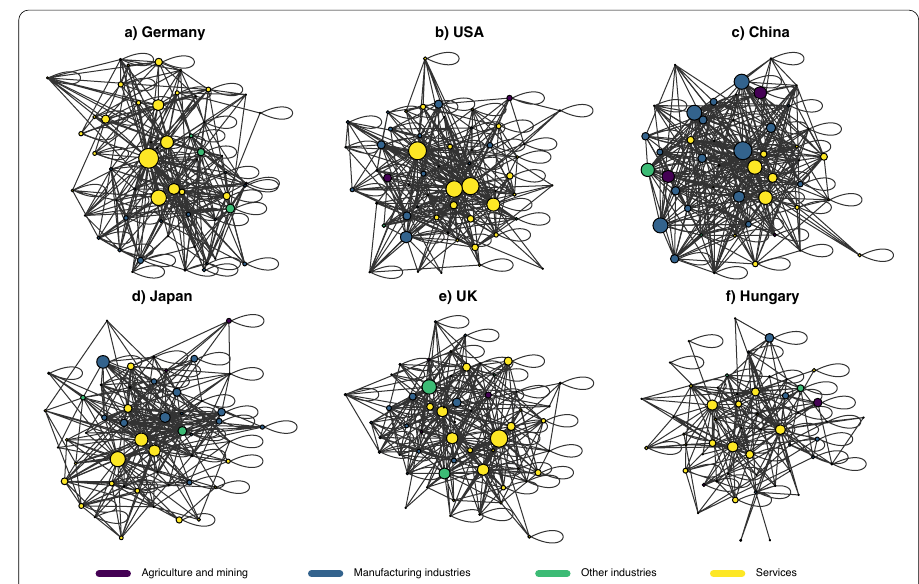
Fig. 4 Six different domestic production networks. The size of the nodes reflect the importance of sectors, measured by their out-degree centrality. The coloring refer to broad sector categories (dark magenta: agriculture and mining, blue: manufacturing industries, green: other industries, yellow: services). The figure only shows those edges where the input share between two sectors is larger than 1.5%. a Germany, b USA, c